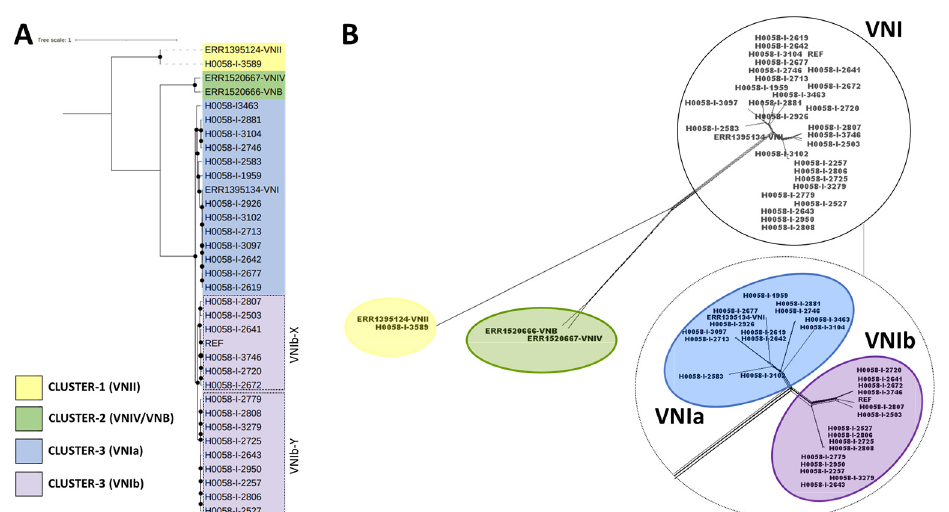
Figure 2. Phylogenetic analysis of Colombian Cryptococcus neoformans genomes. ( A ) Phylogenomic inference based on SNP alignments for the 29 Colombian genomic sequences included in this study. Black dots represent well-supported nodes (bootstrap ≥ 90). ( B ) Phylogenetic networks constructed in SplitsTree 5, based on SNP alignments for 29 Colombian genomes. The bottom figure represents the magnification of cluster 3 (VNI) to visualize the VNI sub ‐ lineages. Genomes representatives for each of the four molecular types previously described for C. neoformans were included: VNI (ERR1395134), VNII (ERR1395124), VNIV (ERR1520667), and VNB (ERR1520666) .